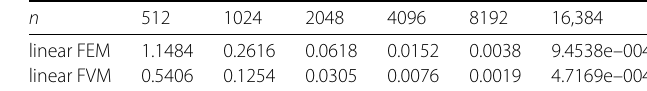
Table 5 The error in the relative discrete H 1 -seminorm for problem (5.1) with k = 200